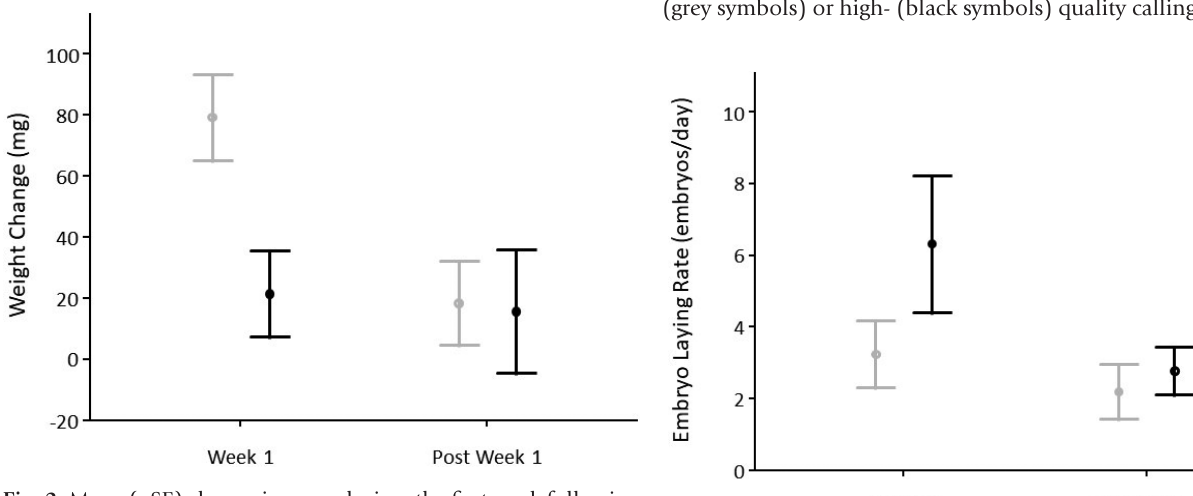
Fig. 2. Mean (±SE) change in mass during: the first week following treatment (Week 1), and the subsequent weeks following treat- ment (Post Week 1) of females who experienced either low- (grey symbols) or high- (black symbols) quality calling song. Table 1. Summary of the results of the principal components anal- ysis of the three embryo measures. Values are the factor loadings and percent variance explained by principal component one.